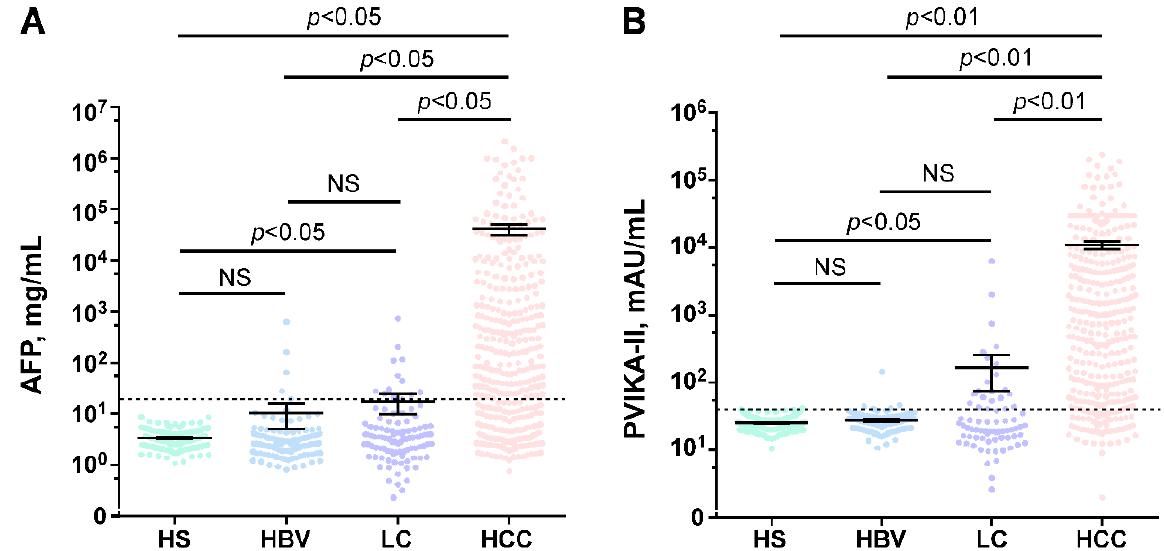
Figure 1. Serum AFP and PIVKA-II concentrations in different populations. ( A ) Serum AFP levels in healthy subjects (HS), chronic HBV infections (HBV), HBV-associate liver cirrhosis (LC), and patients with HBV-related HCC. ( B ) Serum PIVKA-II levels in healthy subjects (HS), chronic HBV infection (HBV), HBV-associated liver cirrhosis (LC), and patients with HBV-related HCC. AFP reference line: 20 ng/mL and PIVKA-II reference line: 40 mAU/mL. Table 2. Univariate and multivariate logistic regression analysis between HCC and liver cirrhosis or HBV infection